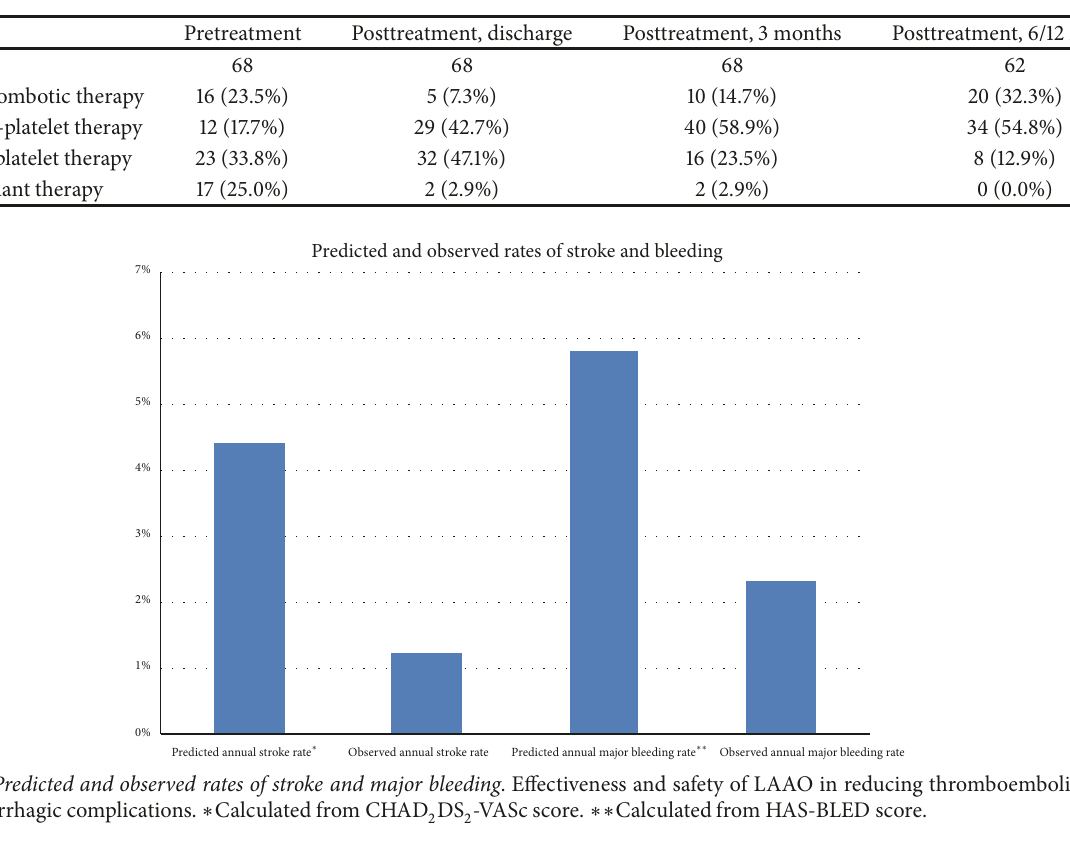
Table 2: Antithrombotic therapy before and after left atrial appendage closure.